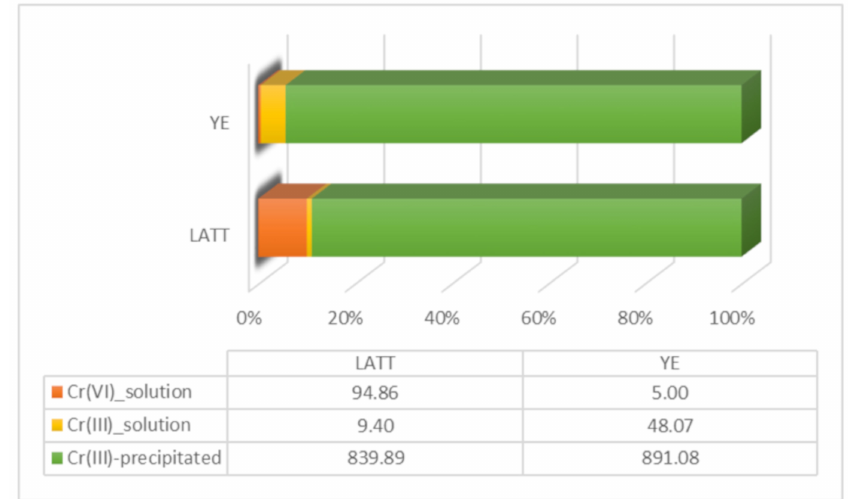
Figure 3. Distribution of Cr fractions in YE and LATT microcosms at the end of the experiment (T5, 28 days). The quantitative data are expressed as µ g / L.